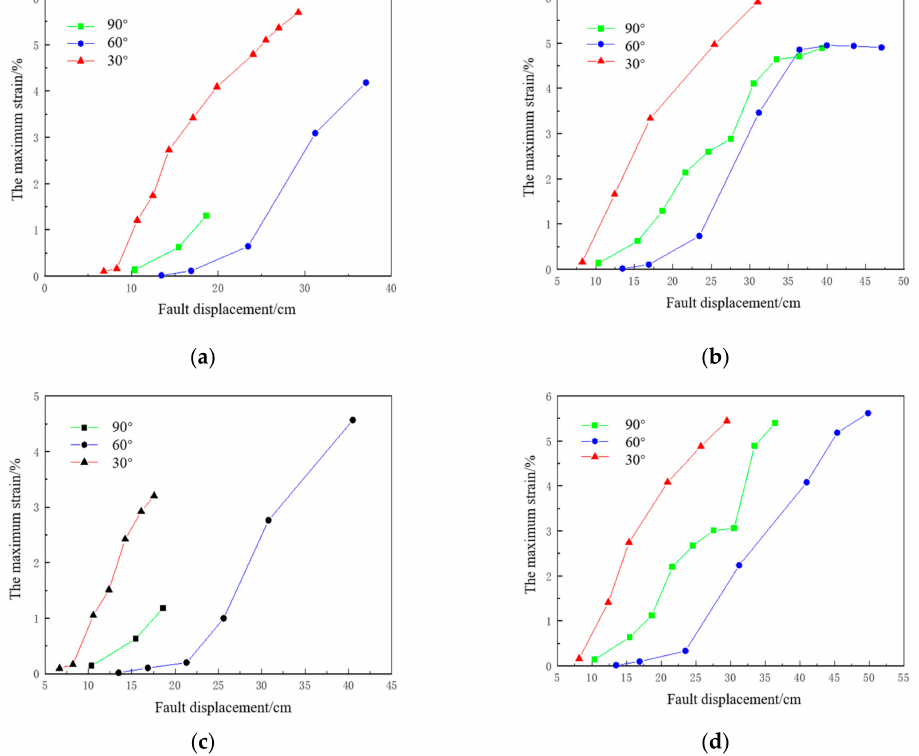
Figure 16. The maximum strain change law of pipeline under different included angles: ( a ) 219.1 × 6.0; ( b ) 219.1 × 6.3; ( c ) 219.1 × 7.0; ( d ) 219.1 ×